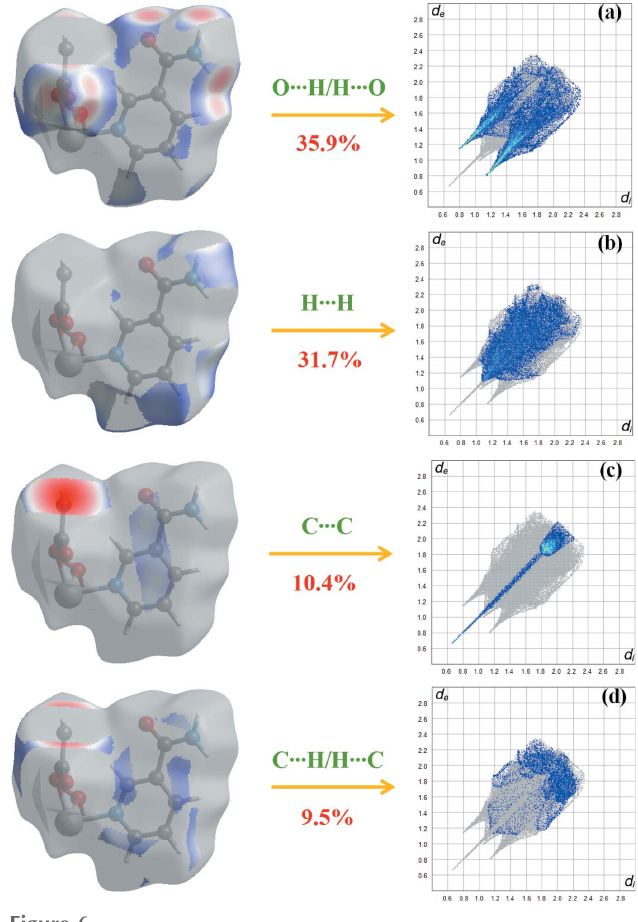
Figure 6 Two-dimensional fingerprint plots with a d norm view of the O (cid:2)(cid:2)(cid:2) H/H (cid:2)(cid:2)(cid:2) O (35.9%), H (cid:2)(cid:2)(cid:2) H (31.7%), C (cid:2)(cid:2)(cid:2) C (10.4%) and C (cid:2)(cid:2)(cid:2) H/H (cid:2)(cid:2)(cid:2) C (9.5%) contacts in the title compound.